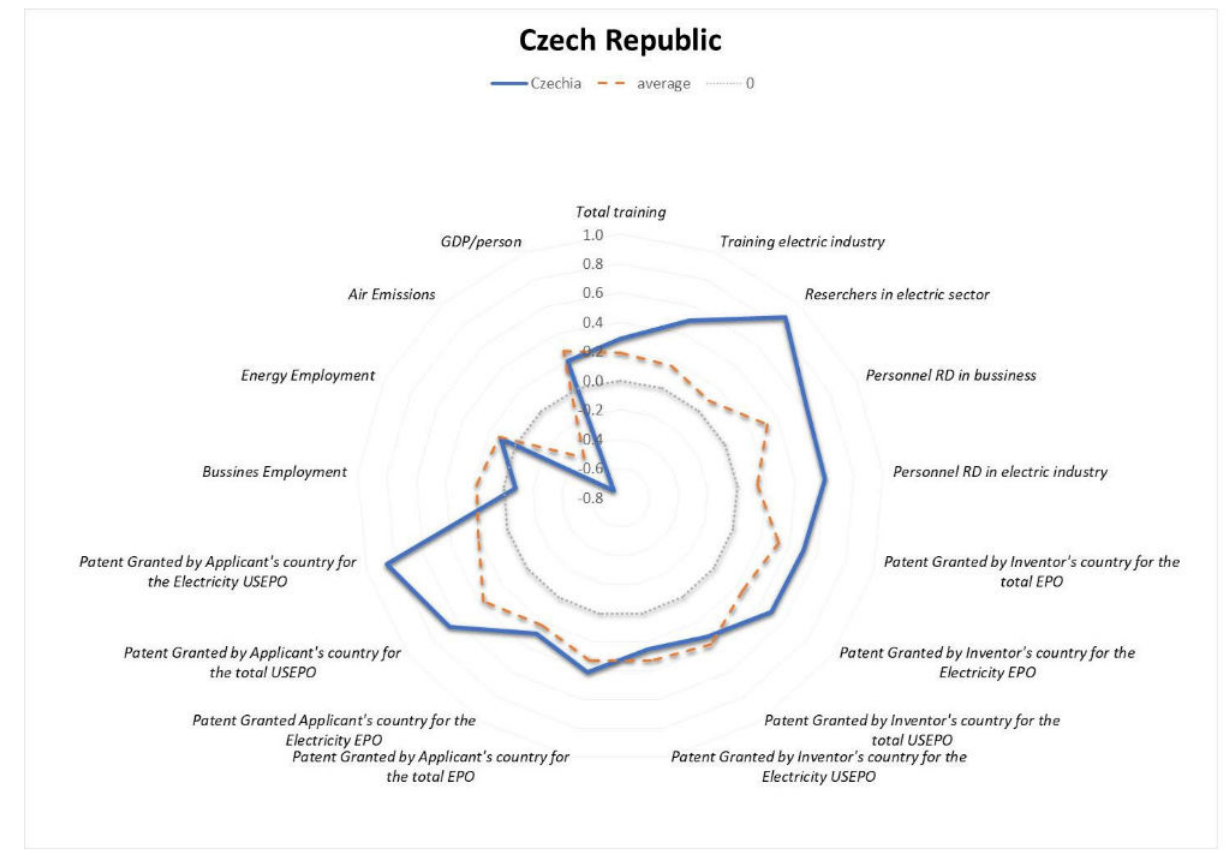
Figure 13. Synergy and trade-off occurrence—CZ. Source: Authors’